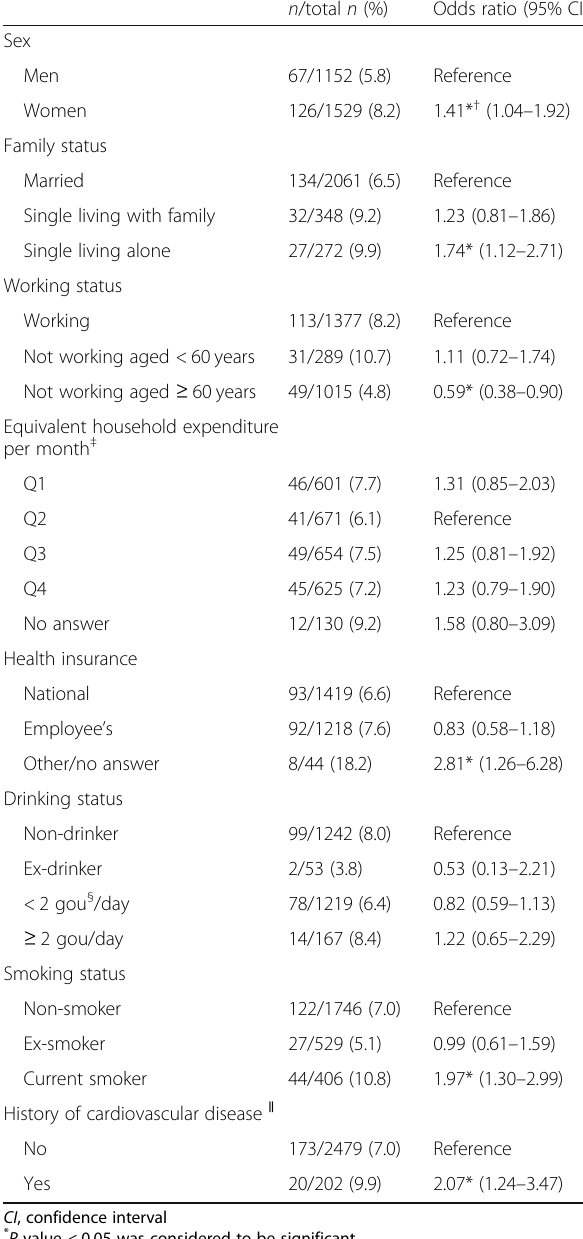
Table 2 Socioeconomic/lifestyle factors and sex-age-adjusted odds ratios of depressive tendencies (Kessler 6 ≥ 9) in Japanese men and women aged 20 years and older. NIPPON